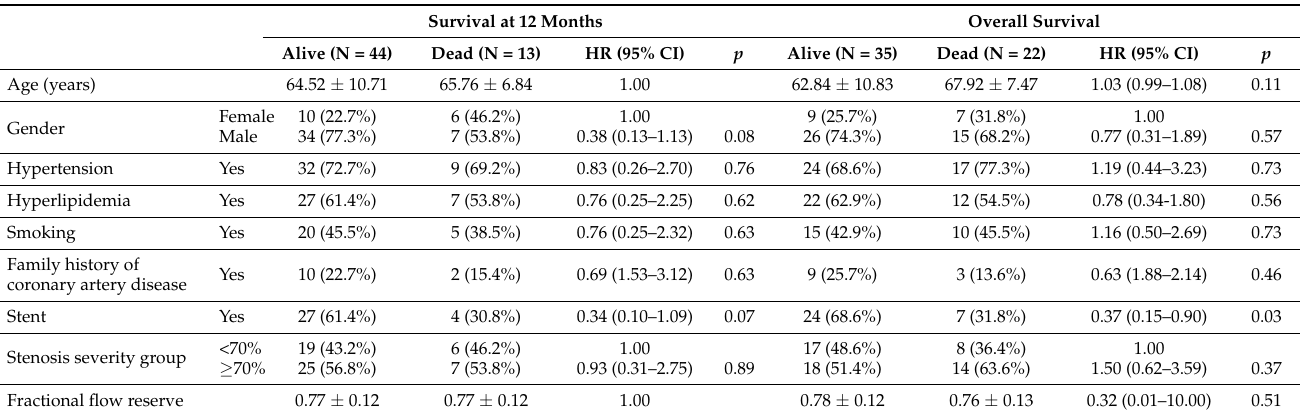
Table 2. Patient characteristics by survival status, univariate Cox regression (censored at last follow-up).